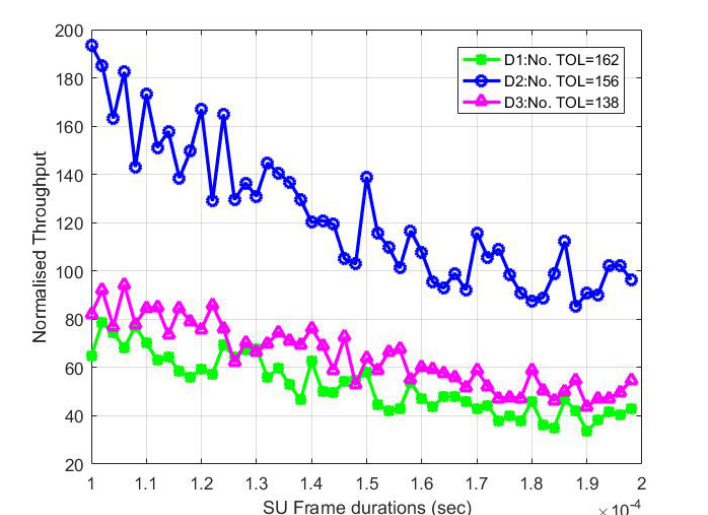
Figure 9. The normalized throughput for the CTOL model with the different numbers of